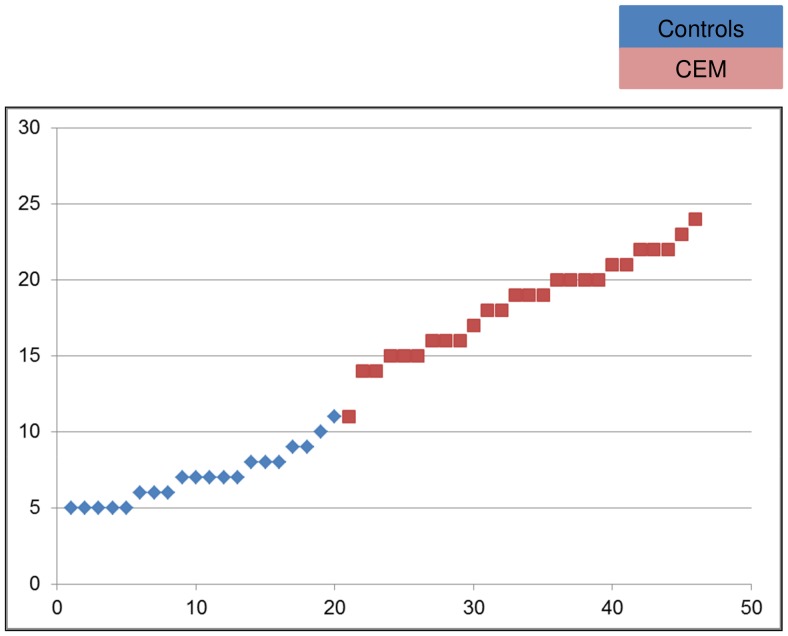
Distribution CEM severity across participants.